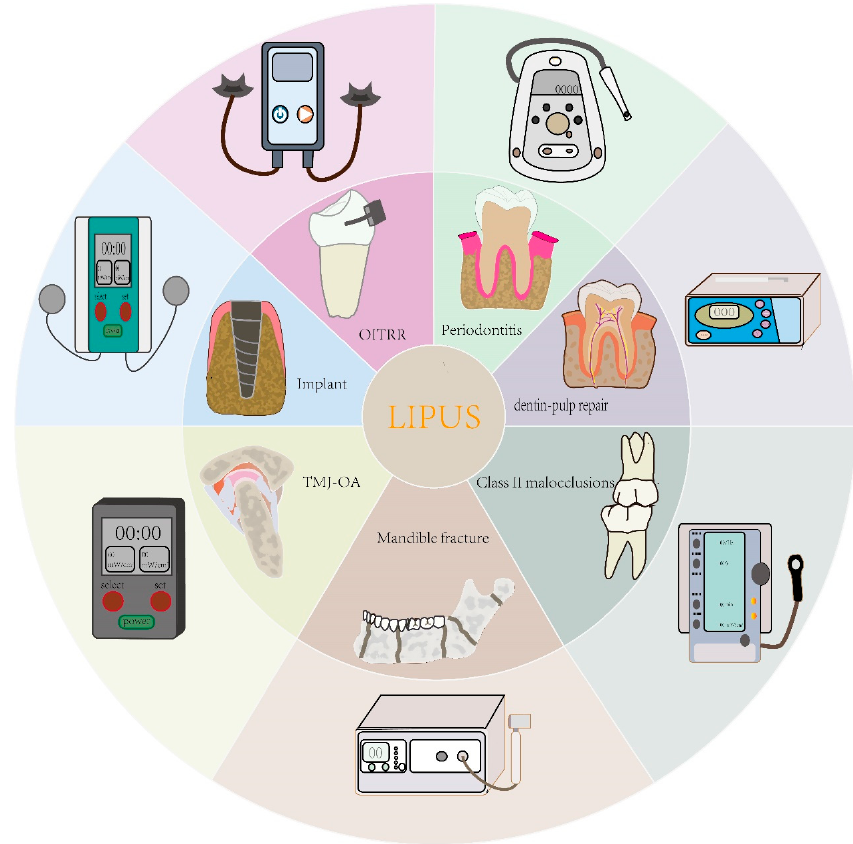
Figure 2. The general devices of LIPUS apply to different oral diseases.